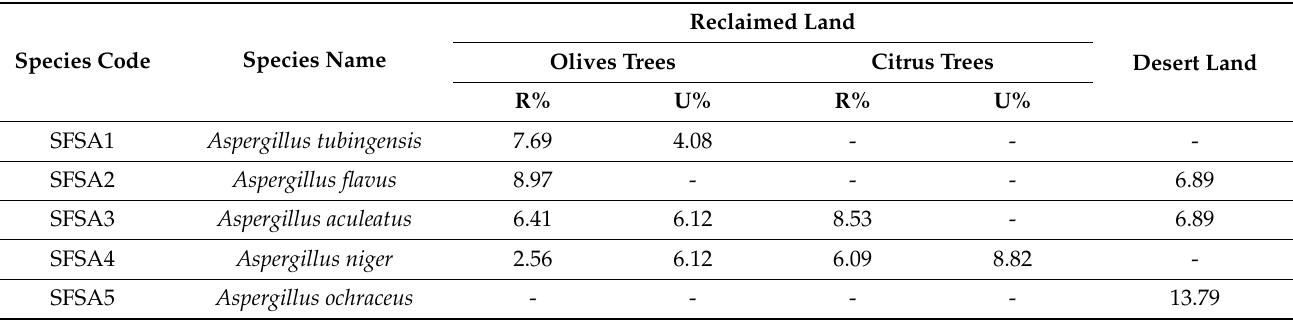
Figure 3. The morphological growth of the pure colonies isolated on PDA media from the soil samples: Penicillium oxalicum ( A ); Fusarium acuminatum ( B ), Aspergillus niger ( C ); Chaetomium globosum ( D ); Penicillium digitatum ( E ); Cladosporium herbarum ( F ). Table 3. A list of samples distribution and frequency of the identified fungi in soil by location, crop, and percentage frequency of